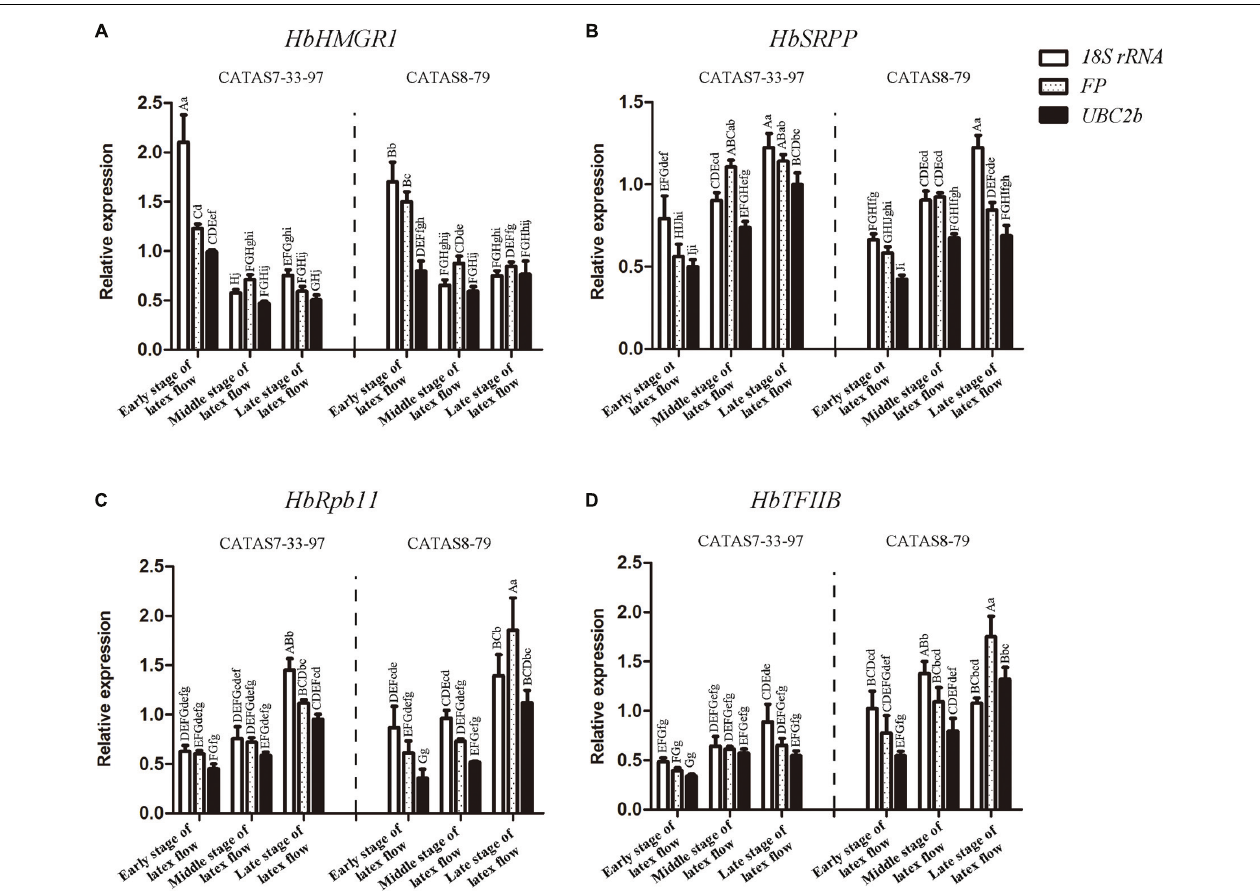
FIGURE 4 | Relative expression of HbHMGR1 (A), HbSRPP (B), HbRpb11 (C) and HbTFIIB (D) by using 18S rRNA , FP or UBC2b for normalization. Error bars for qRT-PCR showed the standard deviation of three replicates. Different letters indicate statistically significant difference in relative expression of each gene among different tissues. The capital letter represents p < 0.01 while lowercase represents p < 0.05. Analyses were performed with SPSS Statistics 17.0. Bars indicate the standard deviation of three biological replicates in triplicate.